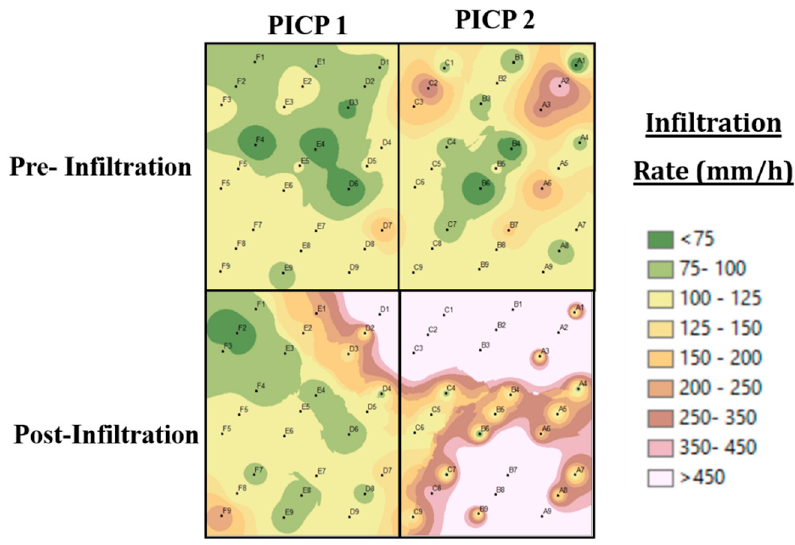
Figure 9. Spatial Variability of Infiltration Capacity at Field Site 1.